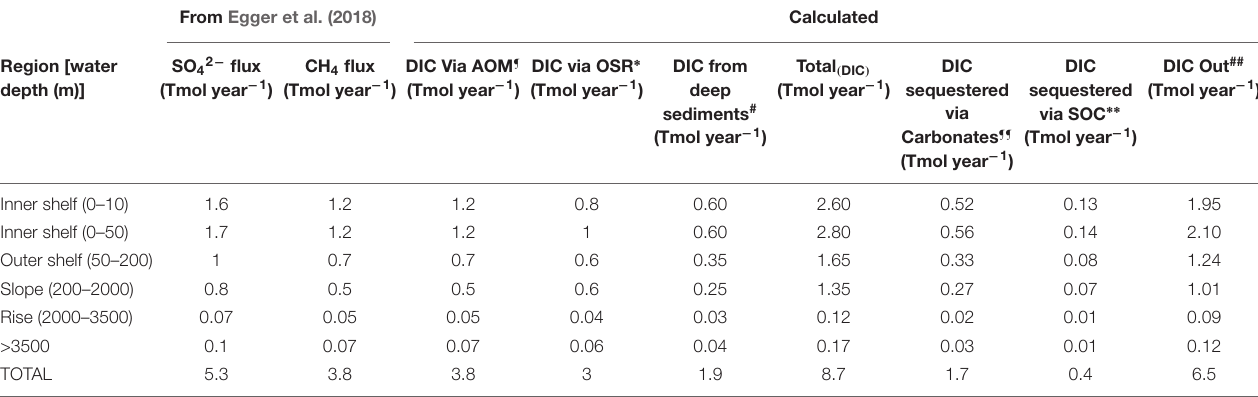
TABLE 3 | Average values for parameters in Table 2 , for a global CH 4 flux of 3.8 Tmol year − 1 and SO 42 − flux of 5.3 Tmol year − 1 . From Egger et al. (2018) Calculated